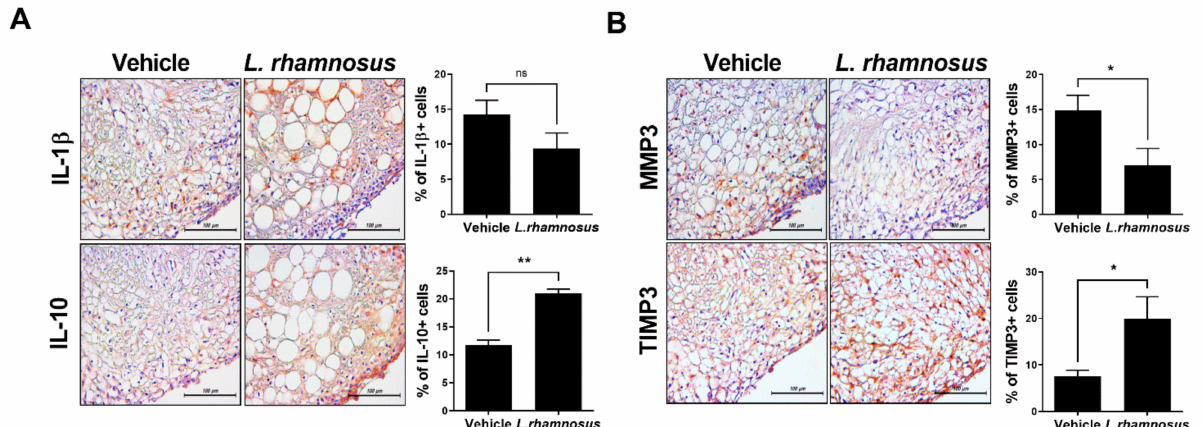
Figure 4. ( A ) Representative images of immunohistochemical staining for IL-1 β and IL-10 in joint synovium of vehicle- treated MIA-induced OA rats and L. rhamnosus (LR-2)-treated MIA-induced OA rats. Bar graphs show average numbers of IL-1 β - and IL-10-positive cells in the joint synovium. ( B) Representative images of immunohistochemical staining for MMP3 and TIMP3 in joint synovium of vehicle-treated MIA-induced OA rats and L. rhamnosus (LR-2)-treated MIA-induced OA rats. Bar graphs show average numbers of MMP3-, and TIMP3-positive cells in the joint synovium. Data are presented as the mean ± SD of three independent experiments. * p < 0.05, ** p < 0.01. ns = not